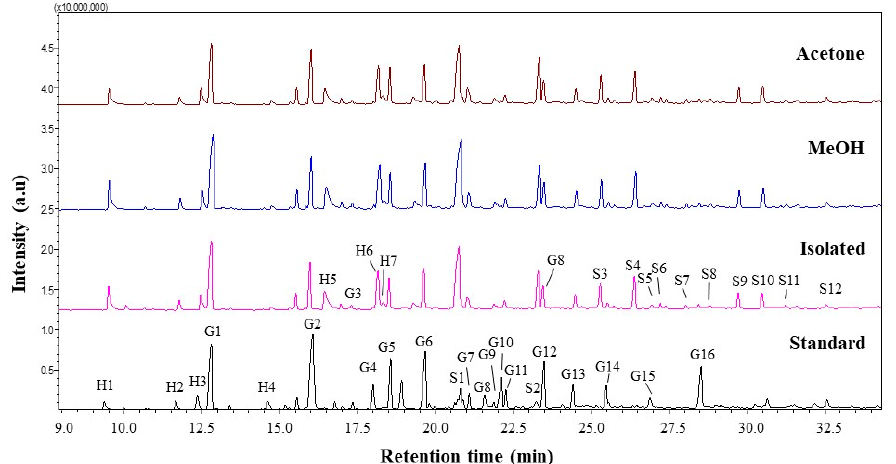
Figure 6. Py ‐ GCMS chromatograms of lignin before and after fractionation. Figure 6. Py-GCMS chromatograms of lignin before and after